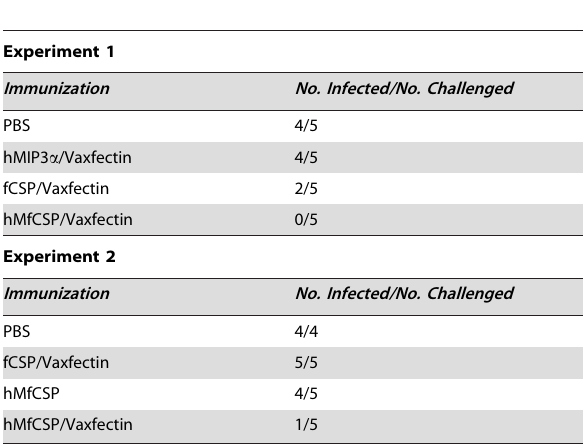
Table 2. Ability of different vaccine constructs to protect against the development of blood stage malaria infection.